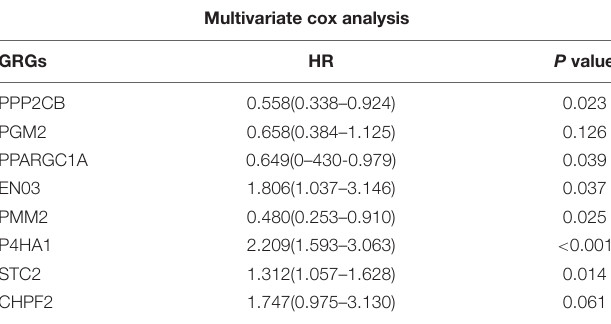
TABLE 2 | Glycolysis related genes Multivariate Cox regression